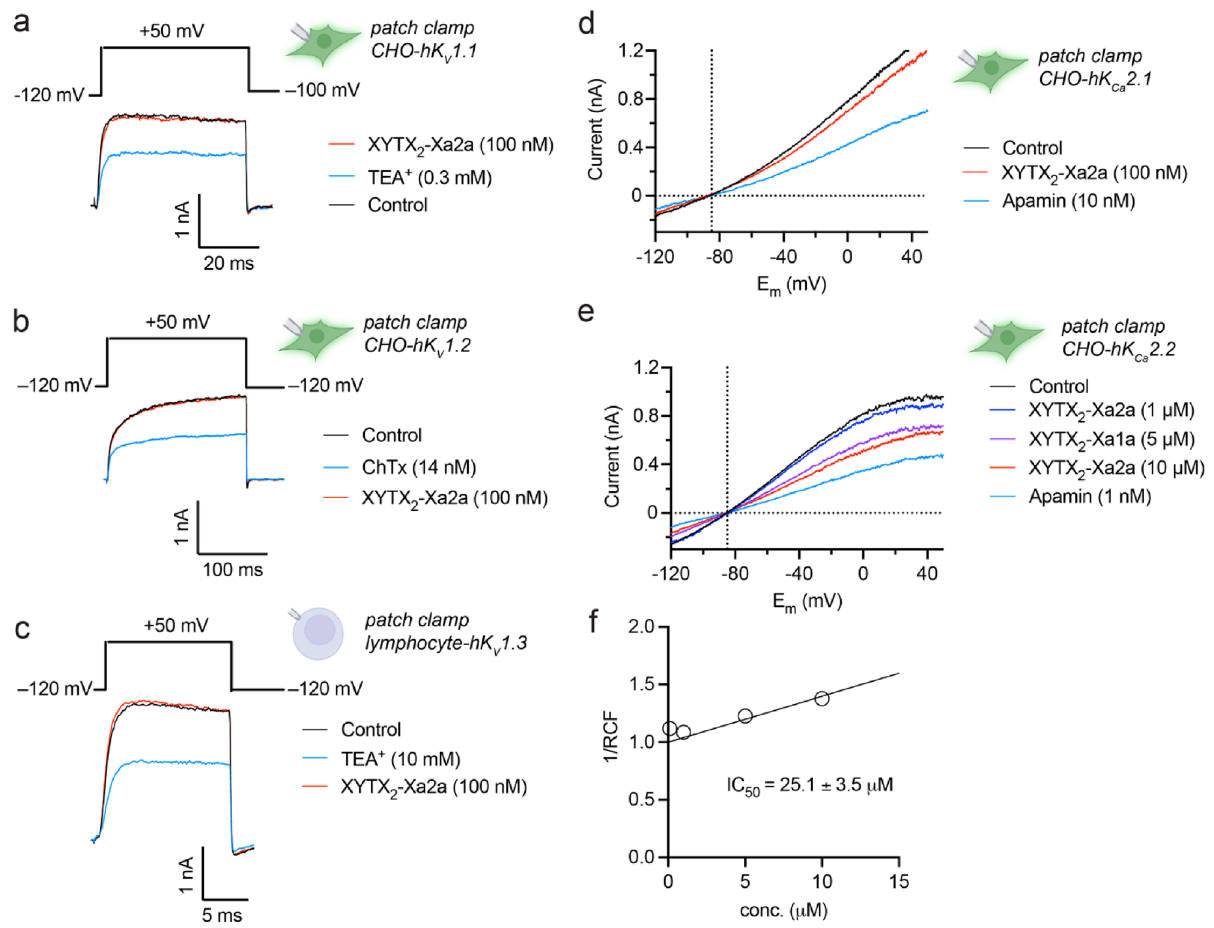
Figure 4. Activity of XYTX 2 -Xa2a on hK V 1.1, hK V 1.2, hK V 1.3, hK Ca 2.1, and hK Ca 2.2 potassium channels. Representative whole-cell current traces were recorded for ( a ) hK V 1.1, ( b ) hK V 1.2, and ( c ) hK V 1.3 using the voltage protocols shown above the raw current traces every 15 s in the absence (black, control) and presence of 100 nM XYTX 2 -Xa2a (orange) and positive control (TEA + for hK V 1.1 and hK V 1.3, and charybdotoxin (ChTx) for hK V 1.2, blue). ( d ) hK Ca 2.1 and ( e ) hK Ca 2.2 currents were elicited with voltage ramps to + 50 mV from a holding potential of − 120 mV every 15 s in the absence (black, control) and presence of XYTX 2 -Xa2a at the indicated concentration (orange) or apamin as a positive control (blue). The currents were corrected for ohmic leakage and then drawn as a function of test potential (E m ). The horizonal dashed line shows the zero current level, the vertical dashed line indicates the expected reversal potential for K + (− 86.5 mV, based on the Nernst equation). ( f ) Low affinity, concentration-dependent block of hK Ca 2.2 channels by XYTX 2 -Xa2a. Whole-cell hK Ca 2.2 currents were recorded using voltage ramps as for ( e ). Remaining current fraction (RCF) was calculated as I / I 0 where I 0 is the peak current at + 50 mV in the absence and I is the peak current at + 50 mV in the presence of XYTX 2 -Xa2a at equilibrium block at concentrations of 0.1, 1, 5, and 10 μM (empty circles), respectively. Points on the linear dose–response curve represent the mean of 4–6 independent measurements. The line was drawn using linear least squares fit (see Methods for details). The reciprocal of the slope of the best fitted line yielded an IC 50 of 25.1 ± 3.5 μM. Data are mean ±